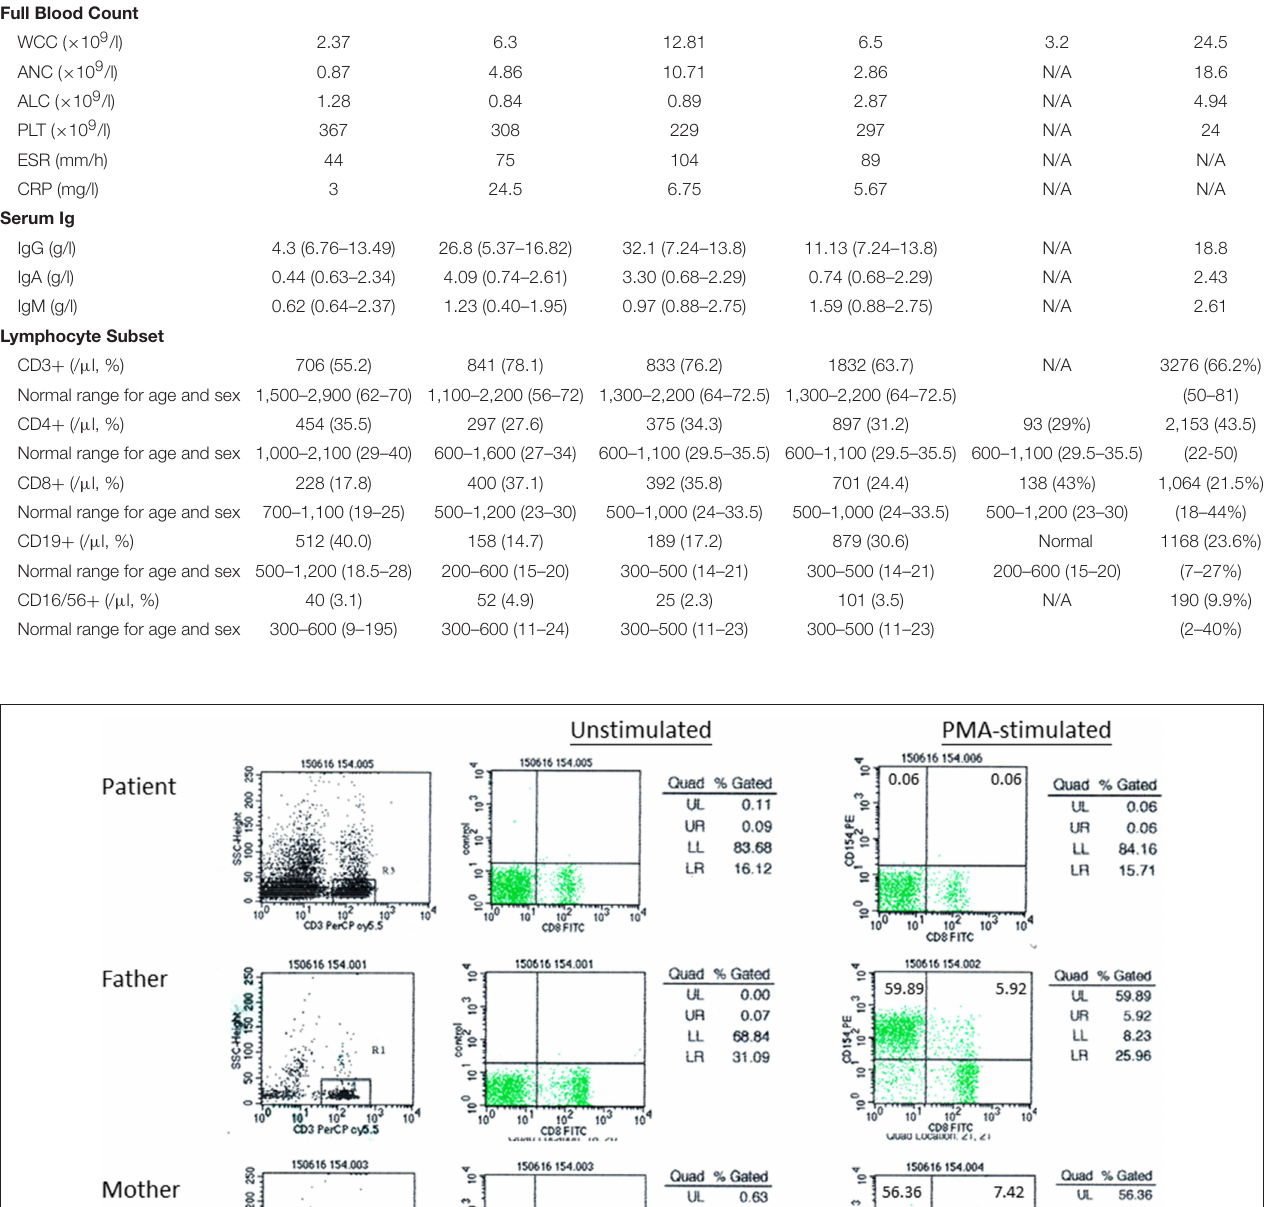
Frontiers in Immunology |